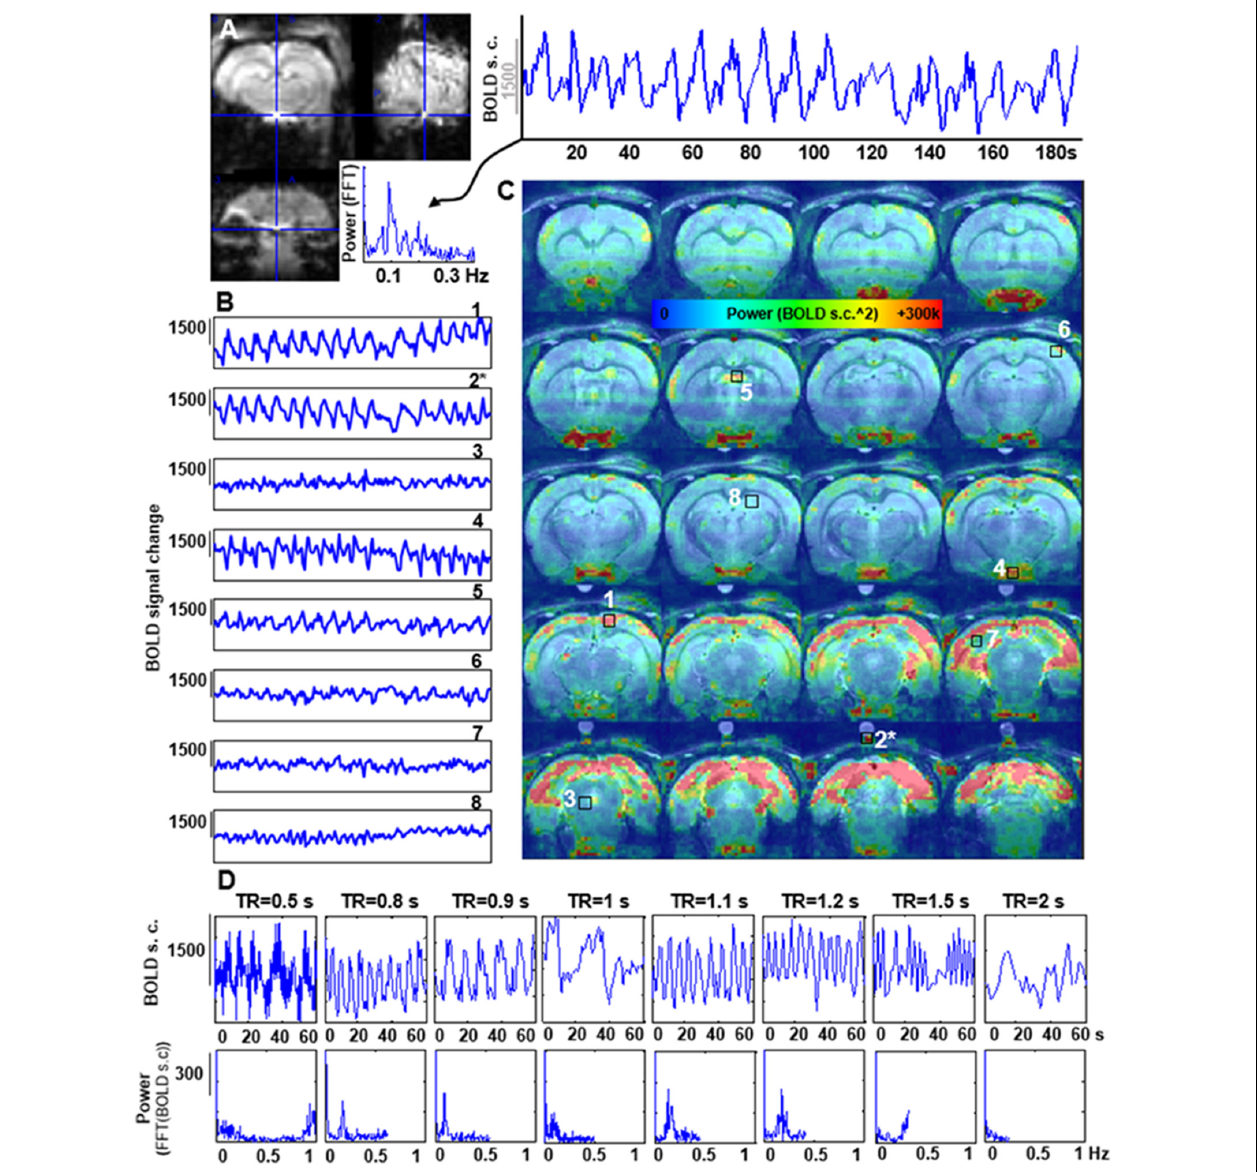
FIGURE 3 | Artifactual slow fMRI waves and TR dependency. (A) Location of the extracted voxel, fMRI time course and PSD from a 3D EPI acquired in an animal breathing spontaneously through a mask, showing an artifactual slow wave with peak frequency of ∼ 0.09 Hz (TR = 0.9 s). (B) The graphs show 180 s of fMRI time course from 8 different voxels in a spontaneously breathing animal (TR = 0.9 s). Numbers indicate the location of the voxels (see C ). ( ∗ ) indicates a phantom voxel (registration is not perfect due to misalignment between the anatomical and functional scan). (C) The map shows the distribution of the power of frequencies within the range 0.005–0.4 Hz. (D) fMRI time courses acquired at eight different TRs in a spontaneously breathing animal (not ventilated). Note how the frequency of the artifactual oscillations changes according to the chosen